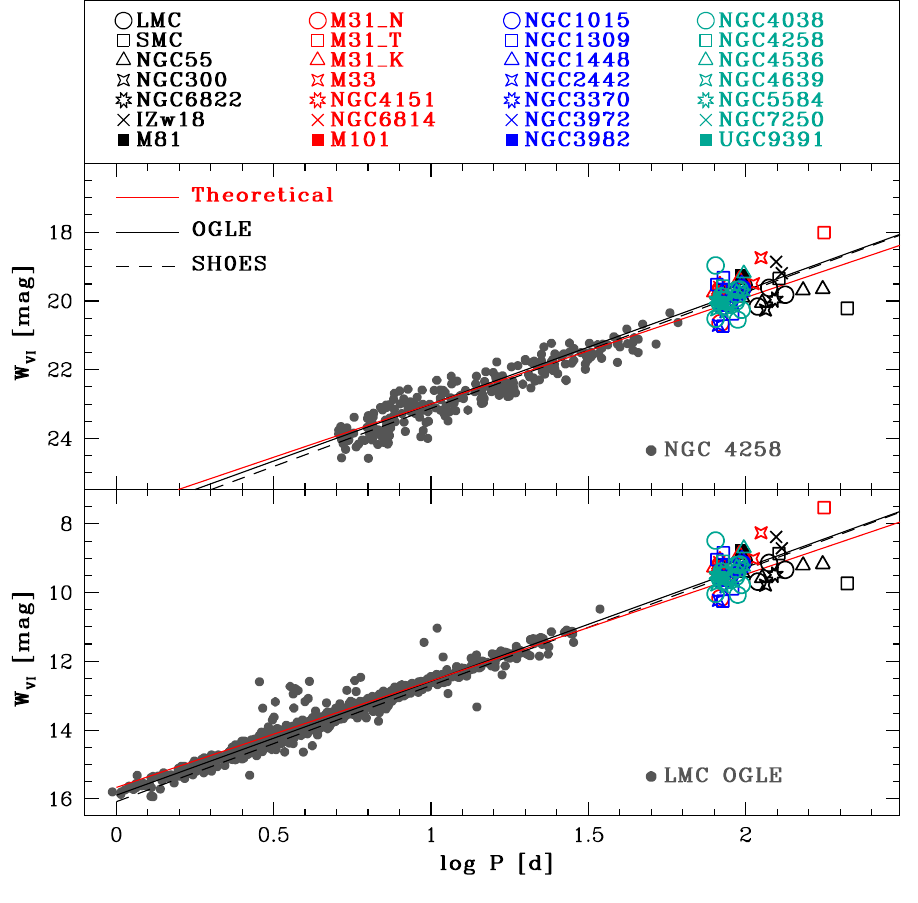
Figure 1. W VI of the ULPs in Table 1 compared with NGC 4258 (grey dots in the upper panel; [16,17]) and LMC OGLE (grey dots in the bottom panel; [21]) CC samples, respectively. The black dashed line and the black solid in the bottom one represent the VI Wesenheit obtained by the SH0ES project [16] and by Soszy´nski et al. [21] for the LMC OGLE CC sample, respectively. The red line represents the theoretical metal dependent W T for the CCs obtained by Fiorentino et al. [12], adopting Z = 0.01 VI (see Section 5 for details). The symbols adopted for the ULPs are labeled in the